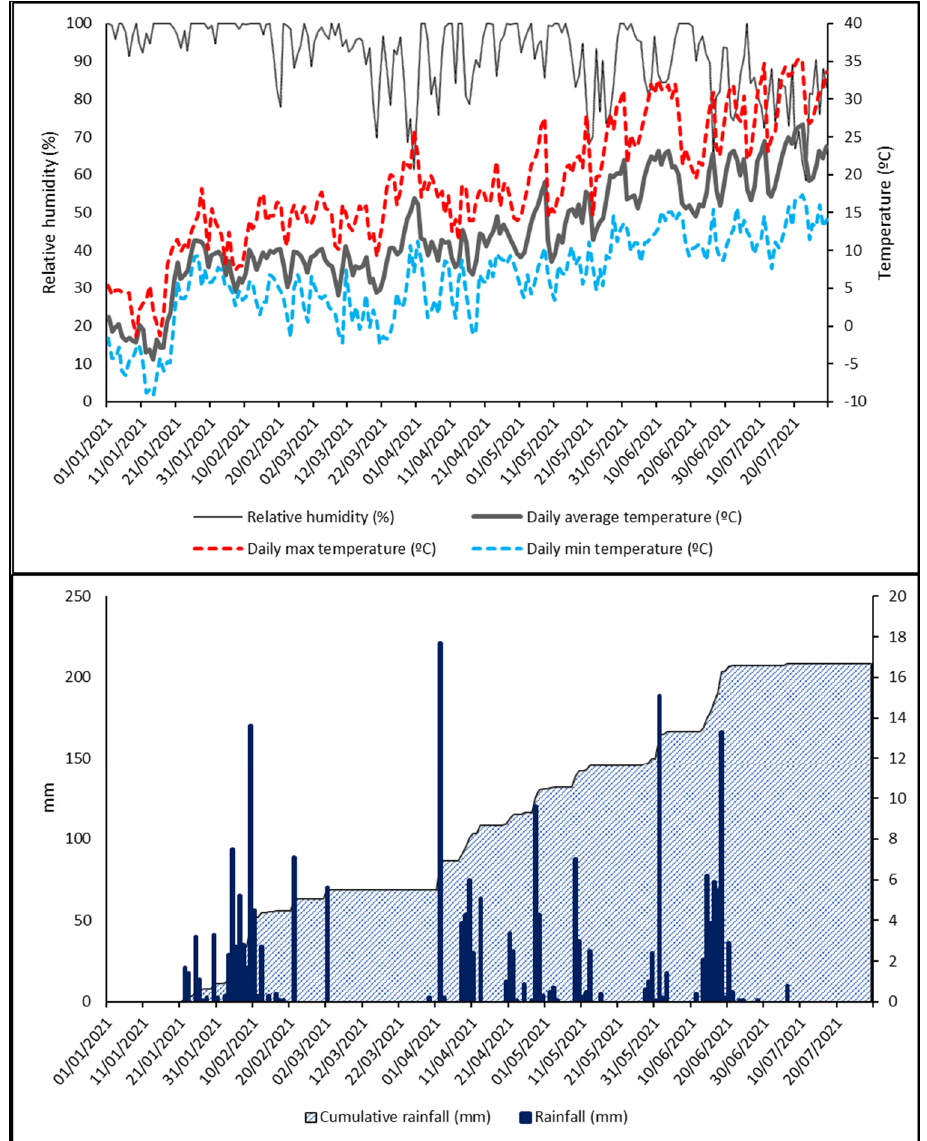
Figure 2. Weather variables over the period from 1 January to 29 July 2021 at the experimental site.